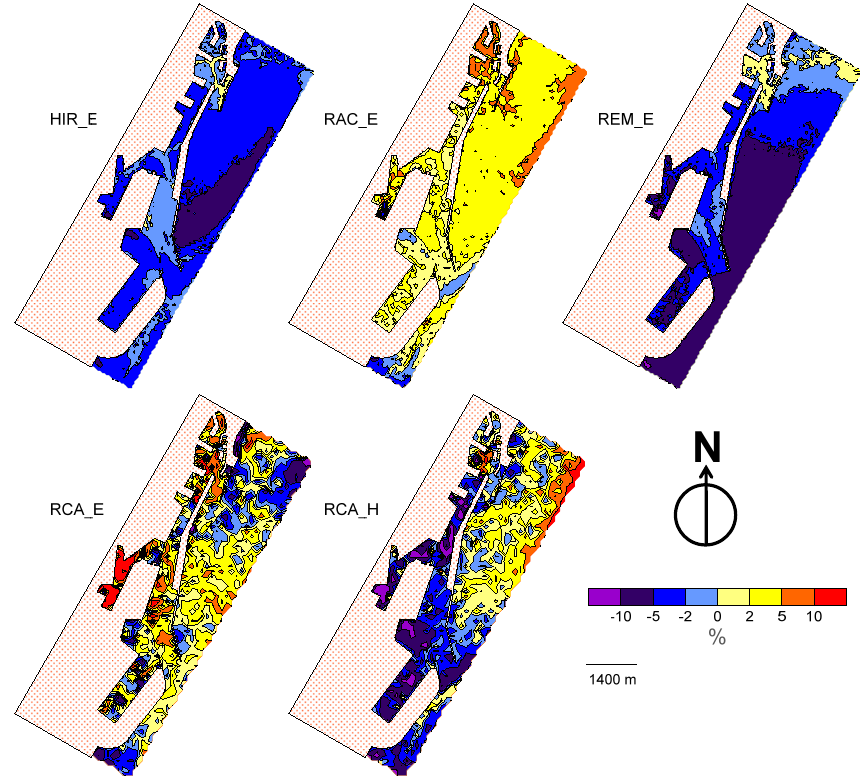
Figure 2. Projected change (future minus present in %) of H s at Barcelona Port for the five